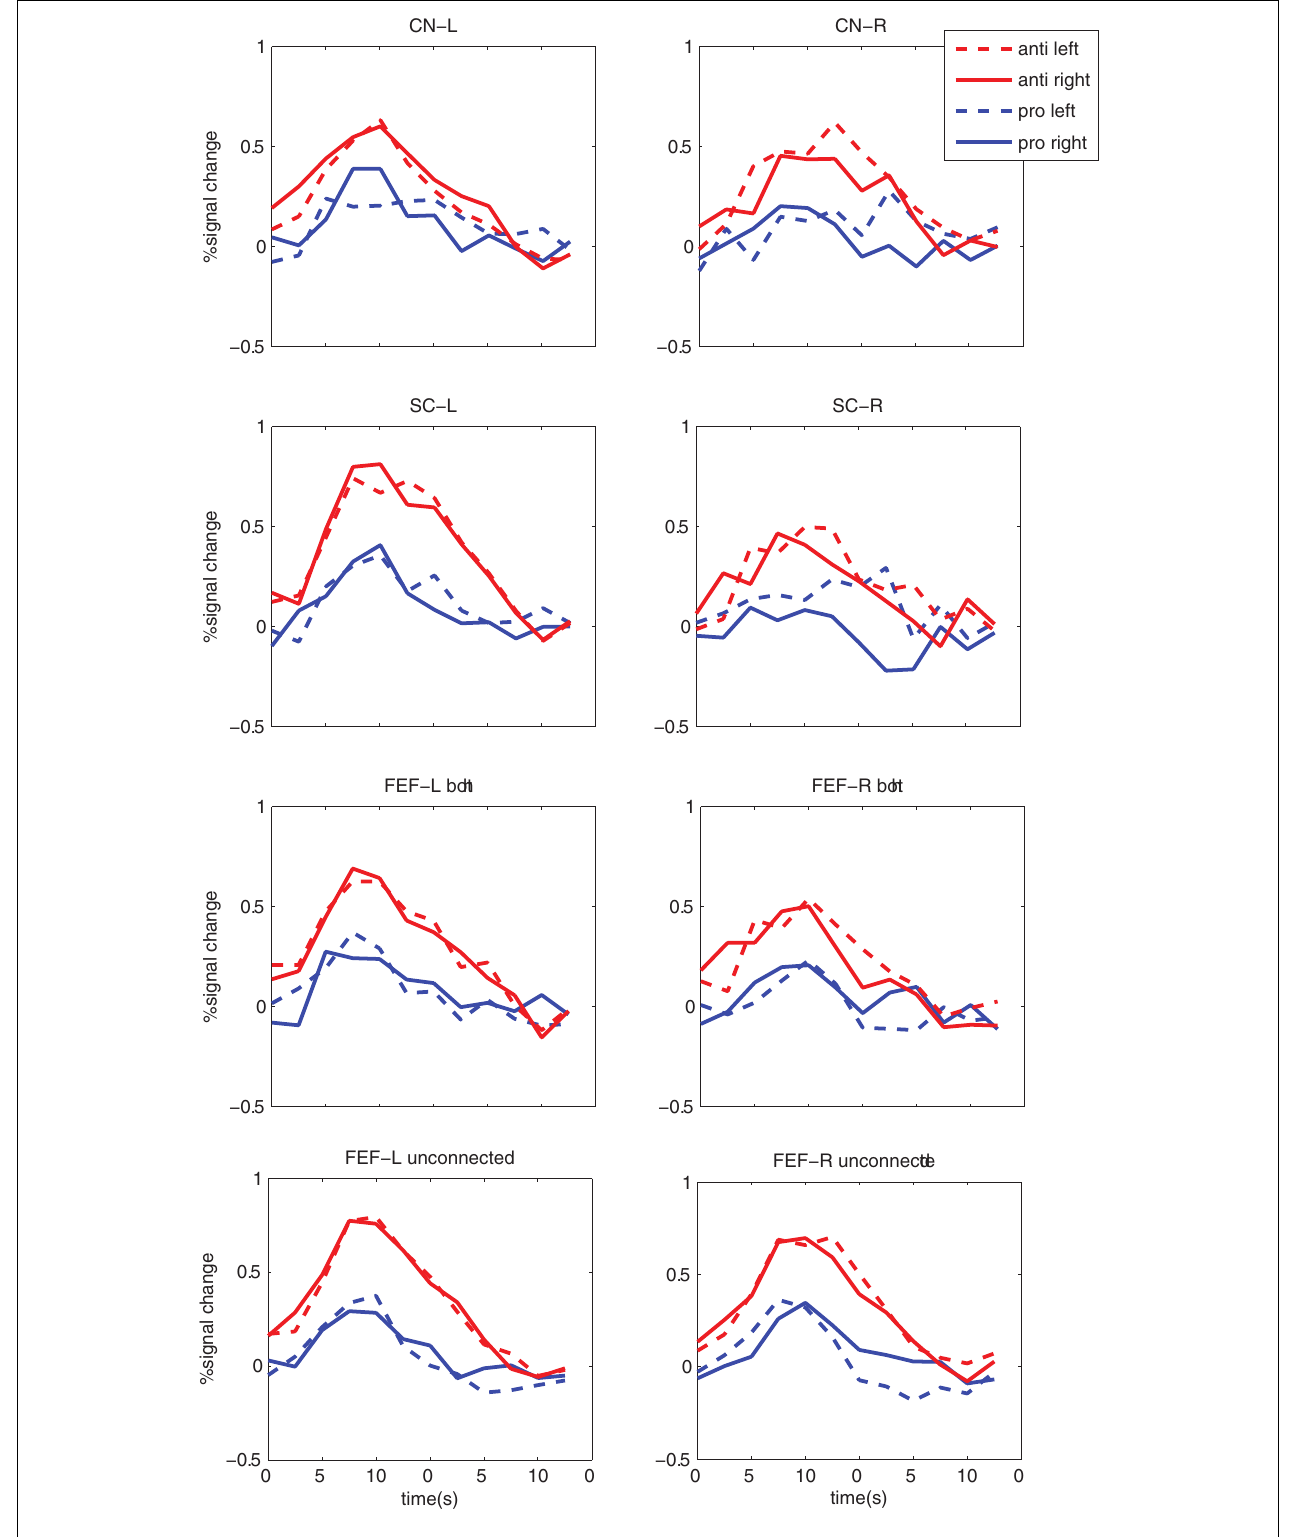
FIGURE 5 | Mean peri-stimulus time histogram (PSTH) of the average BOLD response with respect to time after target presentation for each stimulus condition (pro- or anti, leftward or rightward saccades) and projection